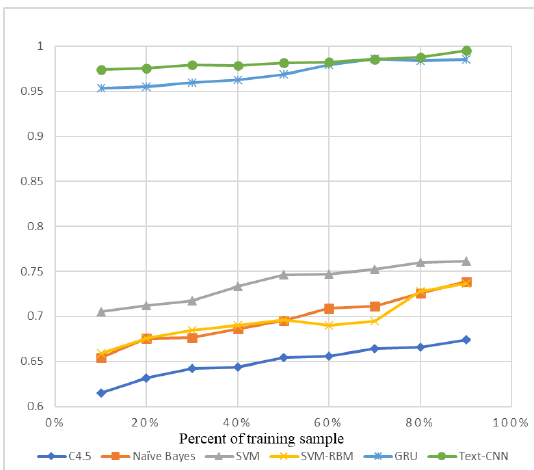
Figure 11. F1-score of ADFA-LD Normal.